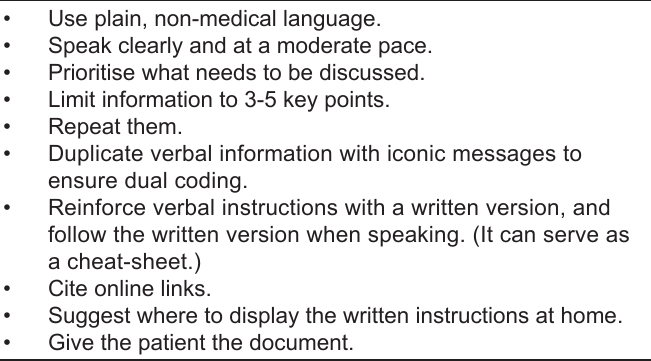
Table 3. Communication strategies to help your patients better understand health